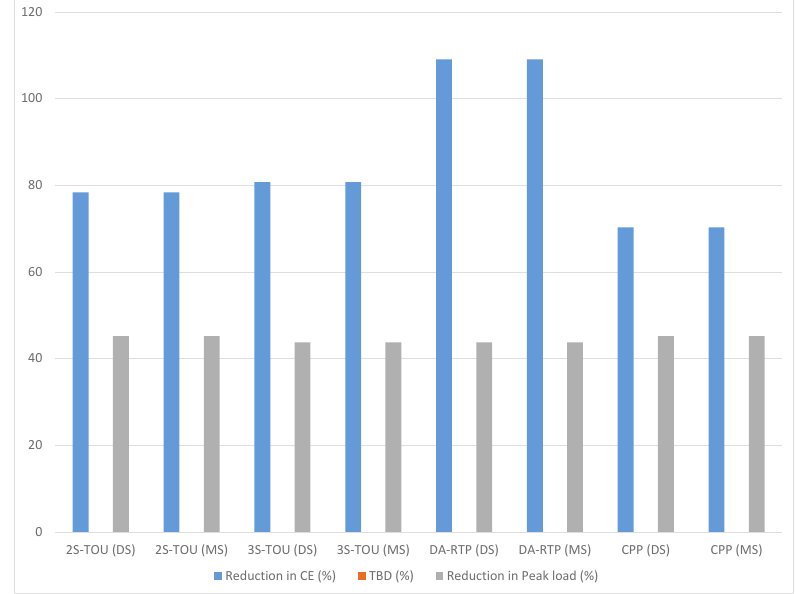
Figure 20. DWS-PSO for RED-based HEMS: A comparative performance at minimal TBD using weights of (0, 1).